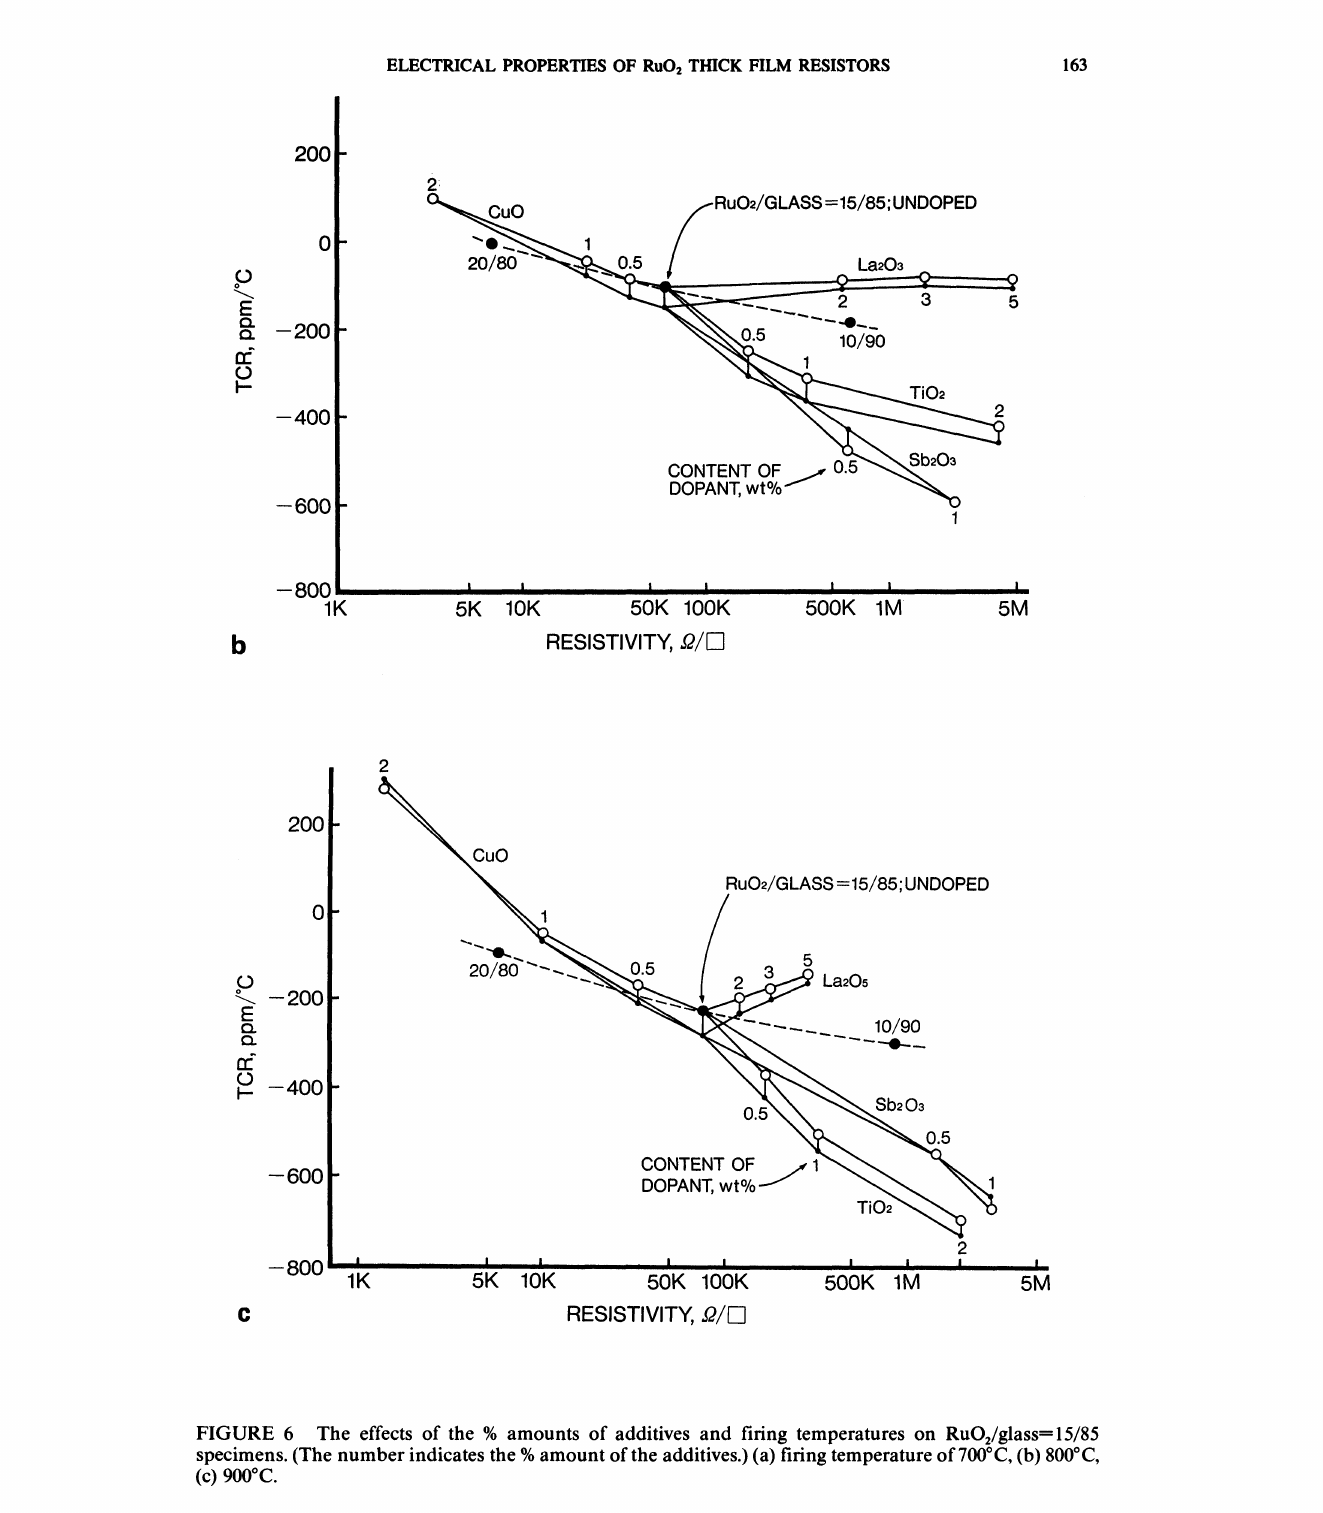
FIGURE 6 The effects of the % amounts of additives and firing temperatures on RuO2/glass=15/85 specimens. (The number indicates the % amount ofthe additives.) (a) firing temperature of 700C, (b) 800C, (c)